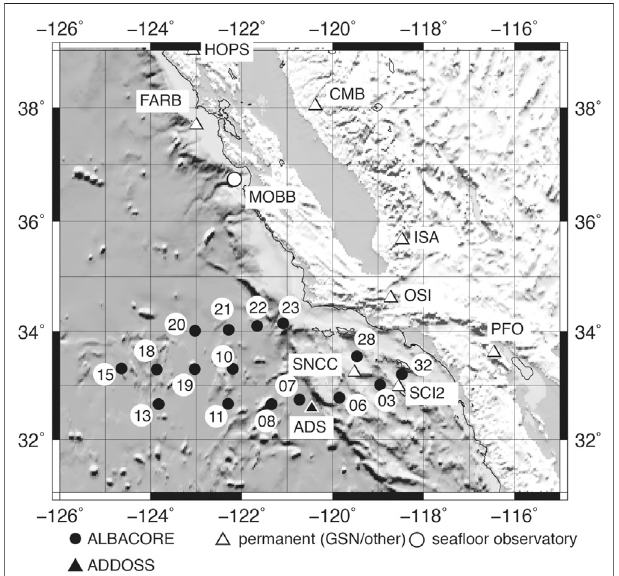
FIGURE 13 | Site locations of the 16 broadband stations of the ALBACOREnetwork(Aug2010 – Sep2011)usedinthisstudy.Alsoshownare sites of permanent observatory stations of the GSN: PFO (Piñon Flat Observatory; primary sensor: STS-1), stations of the CI network (OSI, Osito Adit, STS-1; ISA, Isabella; ,STS-1; SNCC, San Nicolas Island, STS-1; SCI2, San Clemente Island, STS-2), stations of the BK network (HOPS, Hopland Field station, STS-1; CMB, Columbia College, STS-1; BKS, Berkeley, Byerly Vault, STS-1; FARB, Farallon Islands, STS-2) and sea fl oor observatory MOBB (Monterey Bay Broadband Ocean Botton Seismic Observatory, CMG-1T). The ADDOSS OBS as site ADS operated Dec